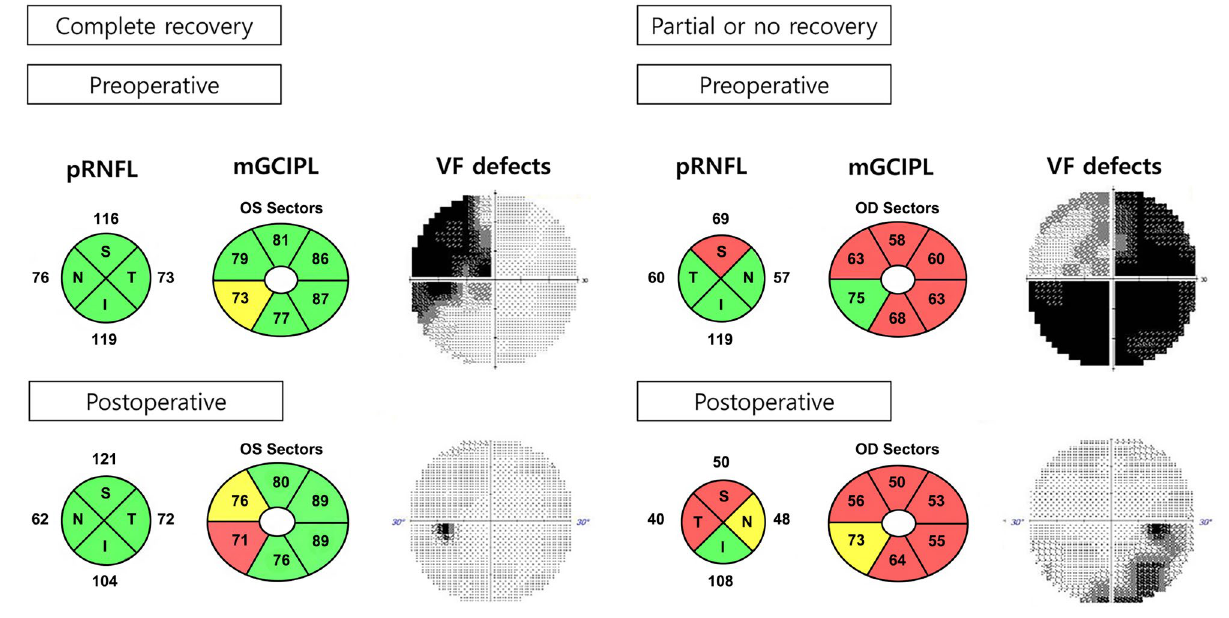
Figure 2. Representative cases in the complete recovery group and the partial or no recovery group of patients with chiasmal compression (both patients showed significant visual field [VF] recovery ≥ 2 dB in the mean deviation). Peripapillary retinal nerve fiber layer (pRNFL) and macular ganglion cell-inner plexiform layer (mGCIPL) thicknesses and VF defects are presented in each group pre- and